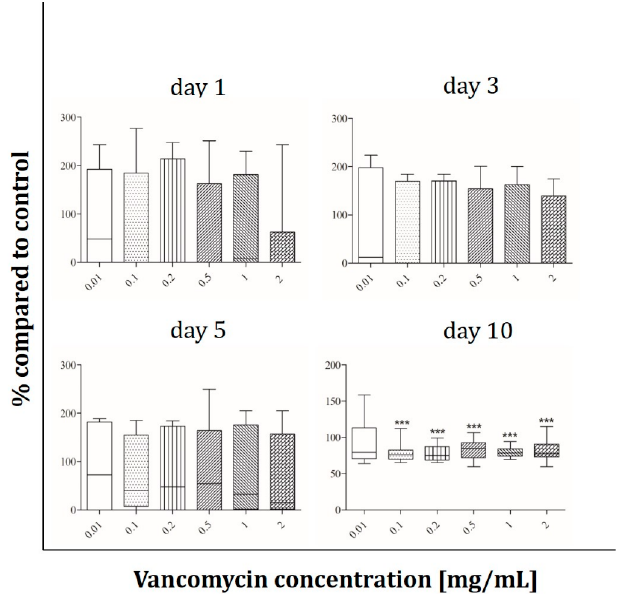
Figure 5. Proliferation of HUVECs after exposure to vancomycin for 1, 3, 5 and 10 days with change of antibiotic every 4 days (* p < 0.05; ** p < 0.01; *** p < 0.001 to control). The results are presented in percentage of the control without vancomycin (100%).